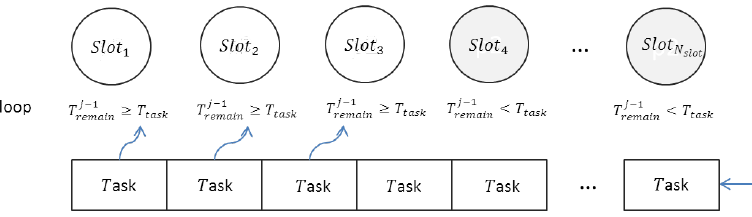
Figure 3. An example status of the j th loop of Equation (2).